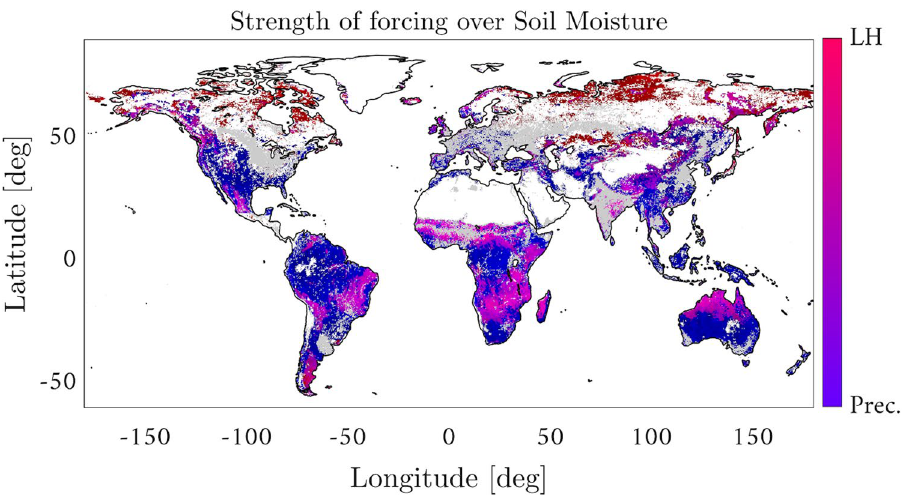
Figure 4. Relative forcings of precipitation and latent heat energy for evaporation on soil moisture. Reddish colors indicate a dominant effect of evaporation processes while bluish colors indicate rainfall water income as the dominant driver for soil moisture variations. The grey areas correspond to crop land areas that have been deliberately masked to avoid confounding effects related with human intervention and its effects on soil moisture. The figure was generated using Matlab version R2018a (https:// es. mathw orks.